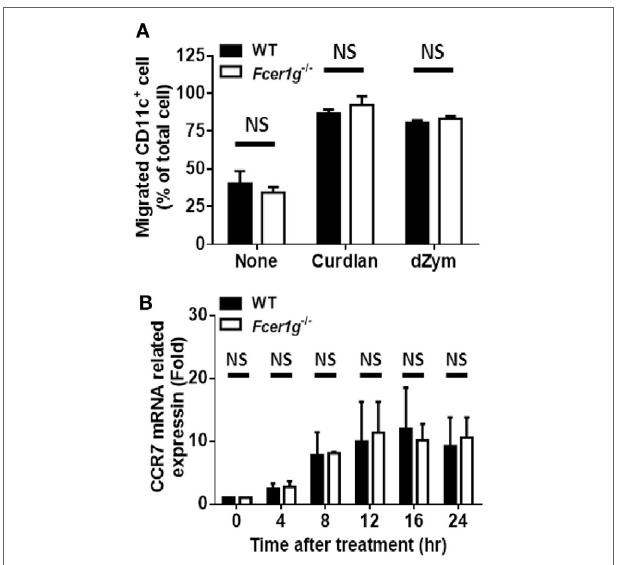
FigUre 5 | Loss of Fc ε RI γ -chain did not change the migration of Dectin-1-activated DCs. BMDCs derived from WT and Fcer1g − / − mice were cultured for 6 days. (a) WT and Fcer1g − / − BMDC cultures were treated with curdlan or dZym for 16 h. Cells were harvested and transferred to upper wells of Transwell chambers, and then CCL21 (200 ng/mL)-containing media were loaded into lower wells. After 3 h, the numbers of CD11c + cell in lower wells were determined by counting and flow cytometry. (B) WT and Fcer1g − / − BMDCs were harvested and treated with dZym for the indicated times. Then, total RNAs were extracted for analyzing CCR7 mRNA level by real-time PCR. The significances NS, not significant (Student’s t -test) were obtained by comparing Fcer1g − / − to WT DCs. Error bars indicated mean + SD of three independent experiments. All data shown are representative from three independent